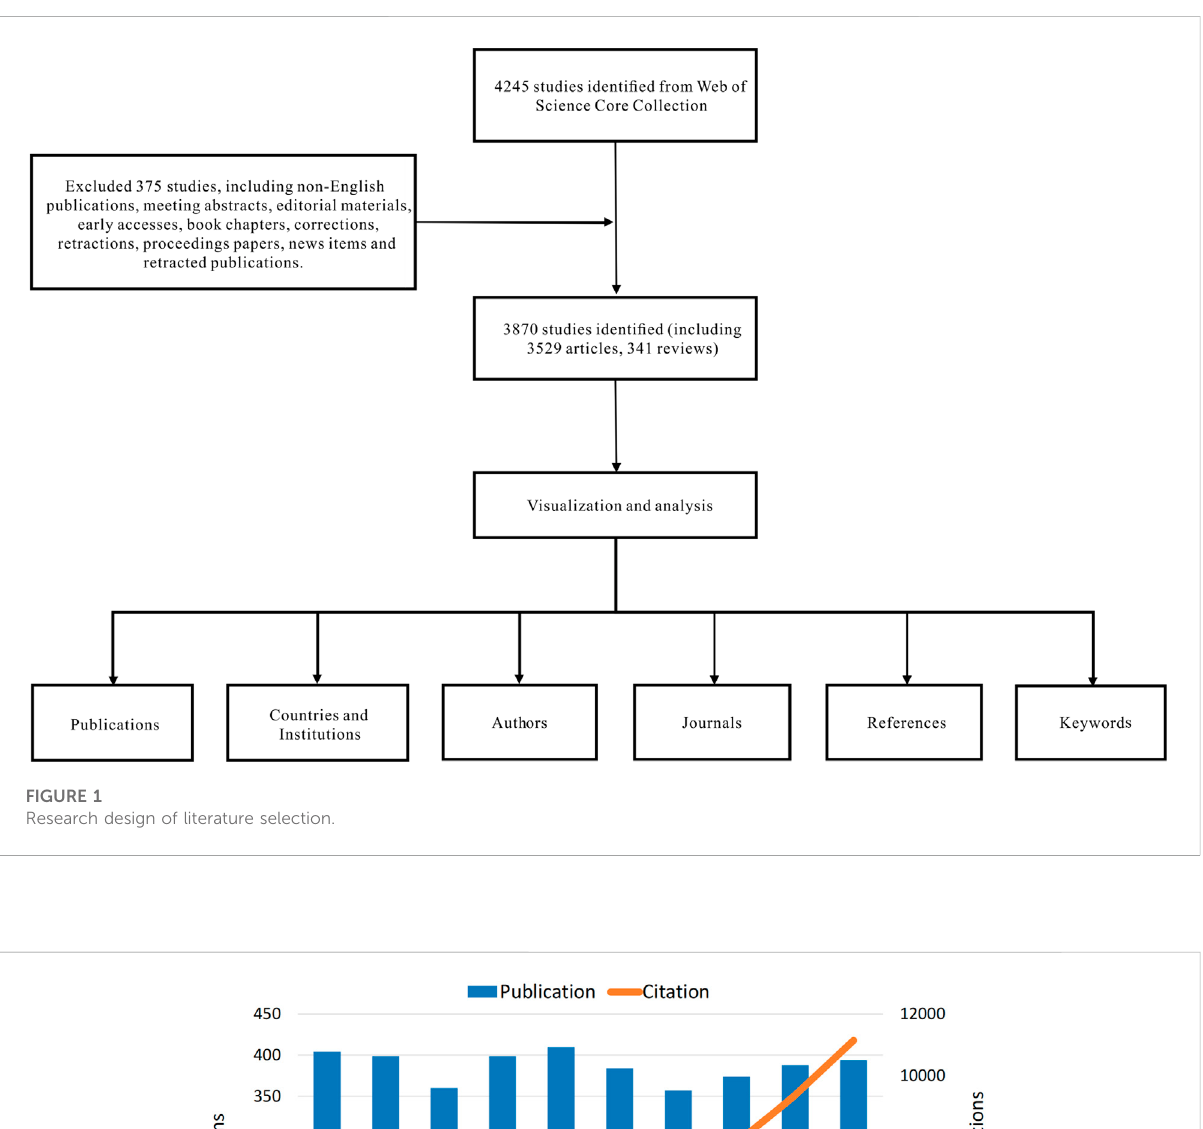
FIGURE 1 Research design of literature selection.